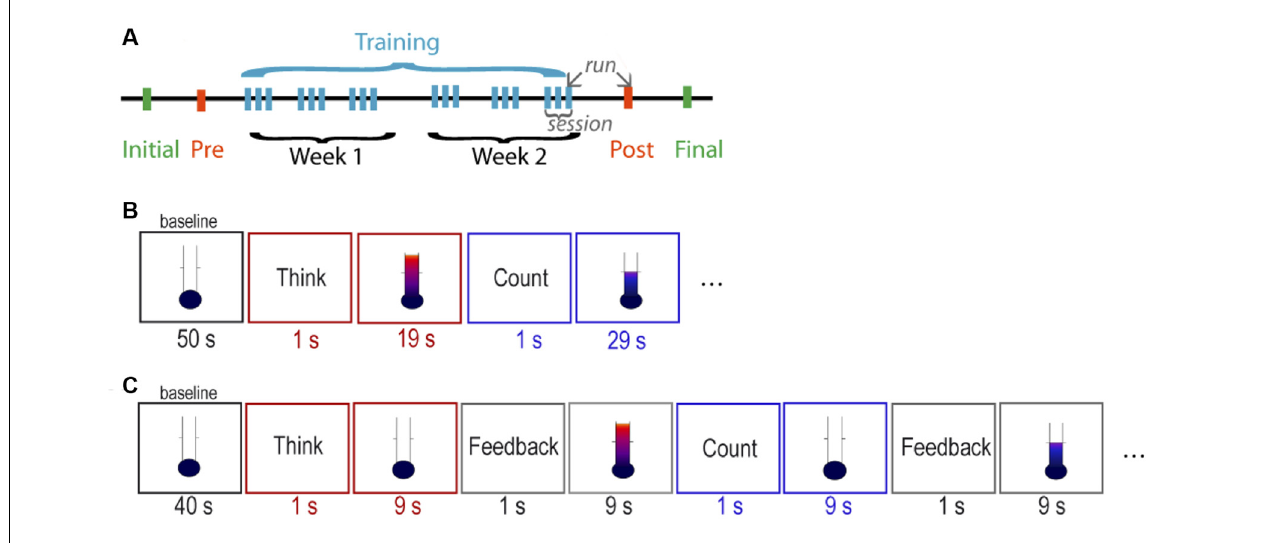
FIGURE 1 | Structure of the neurofeedback (NF) training. (A) Overall structure of the NF study. Schedule of stimuli of the (B) parallel paradigm and the (C) serial